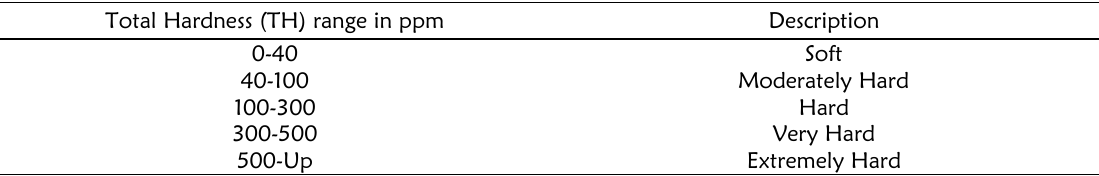
Table 2: Total Hardness range and the quality of water